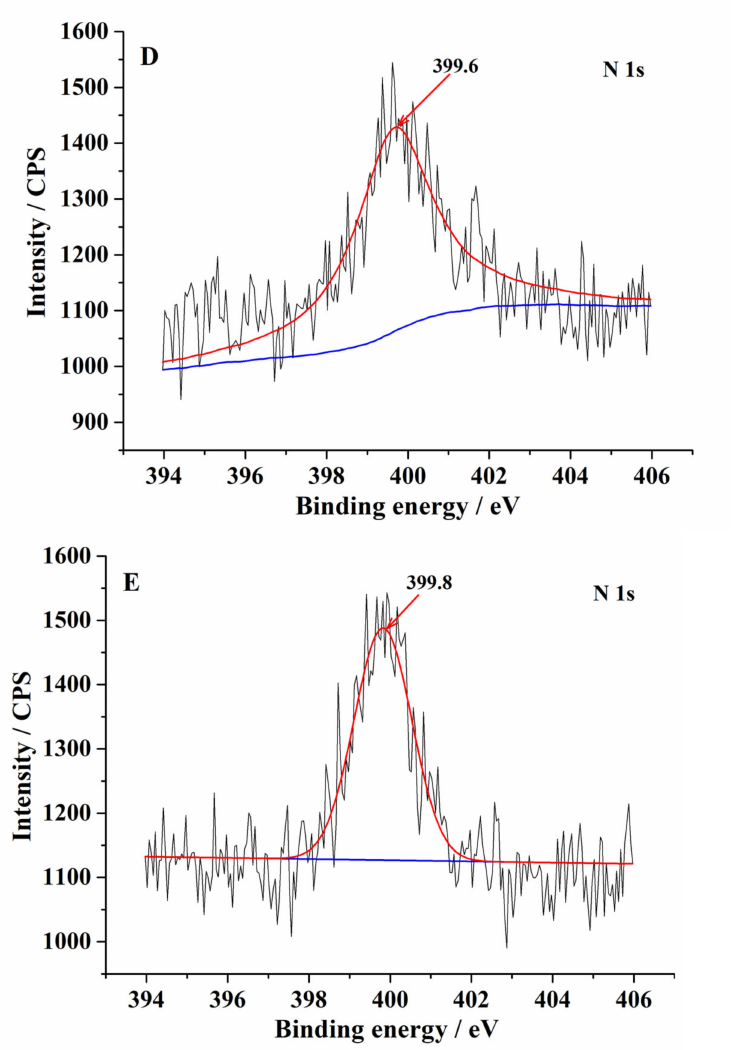
Figure 8. ( A ) XPS spectra of ( a ) CA–SC and ( b ) Mg 2+ -loaded CA–SC; O 1s of ( B ) CA–SC and ( C ) Mg 2+ -loaded CA–SC; N 1s of ( D ) CA–SC; and ( E ) Mg 2+ -loaded